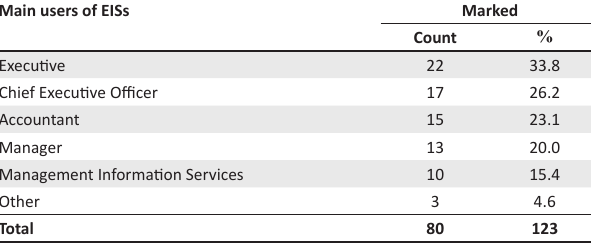
TABLE 6: Main users of Executive Information Systems